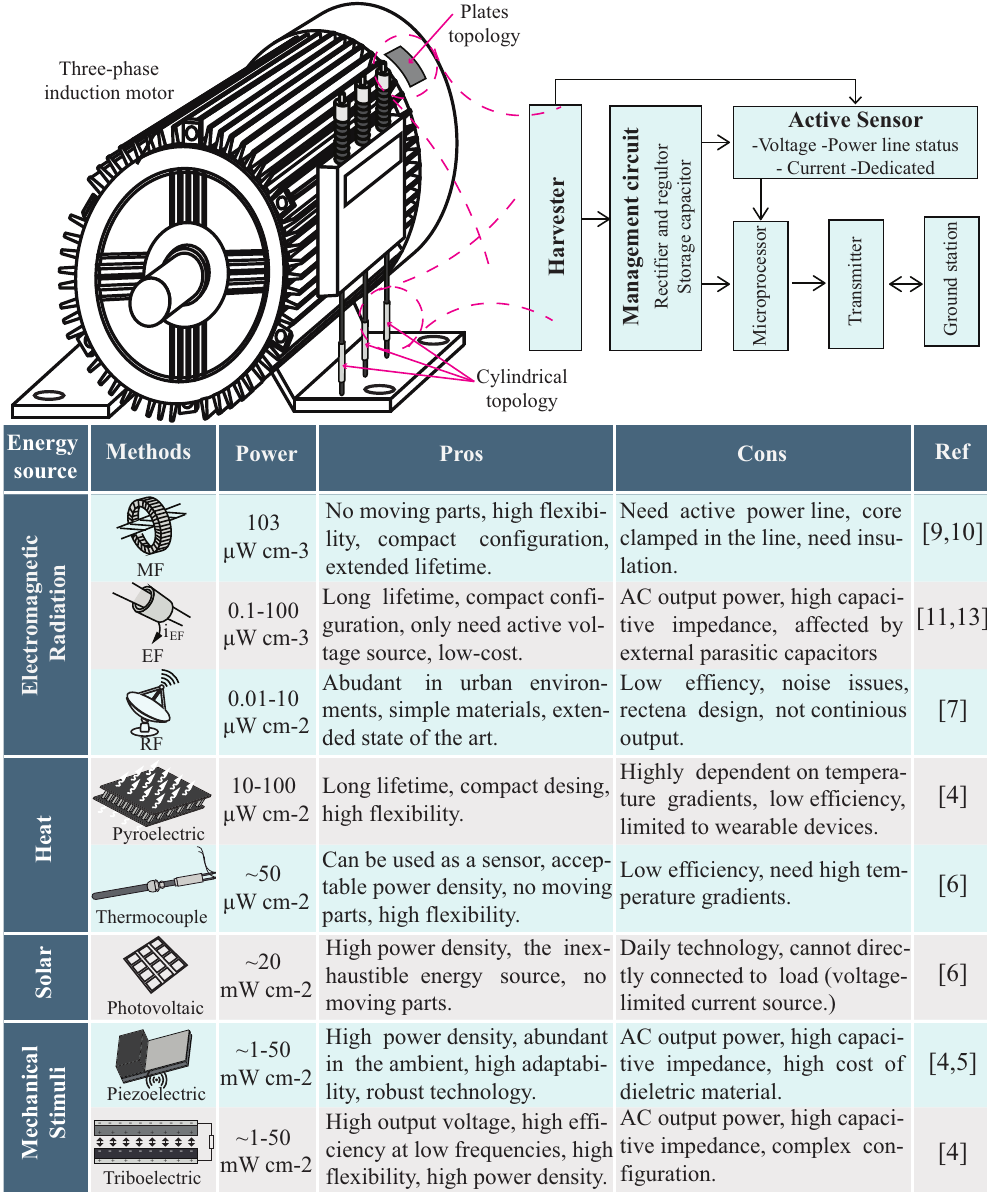
Figure 1. Smart-grid sensor node architectures deployed on the energized wires (both high/medium voltage and low voltage